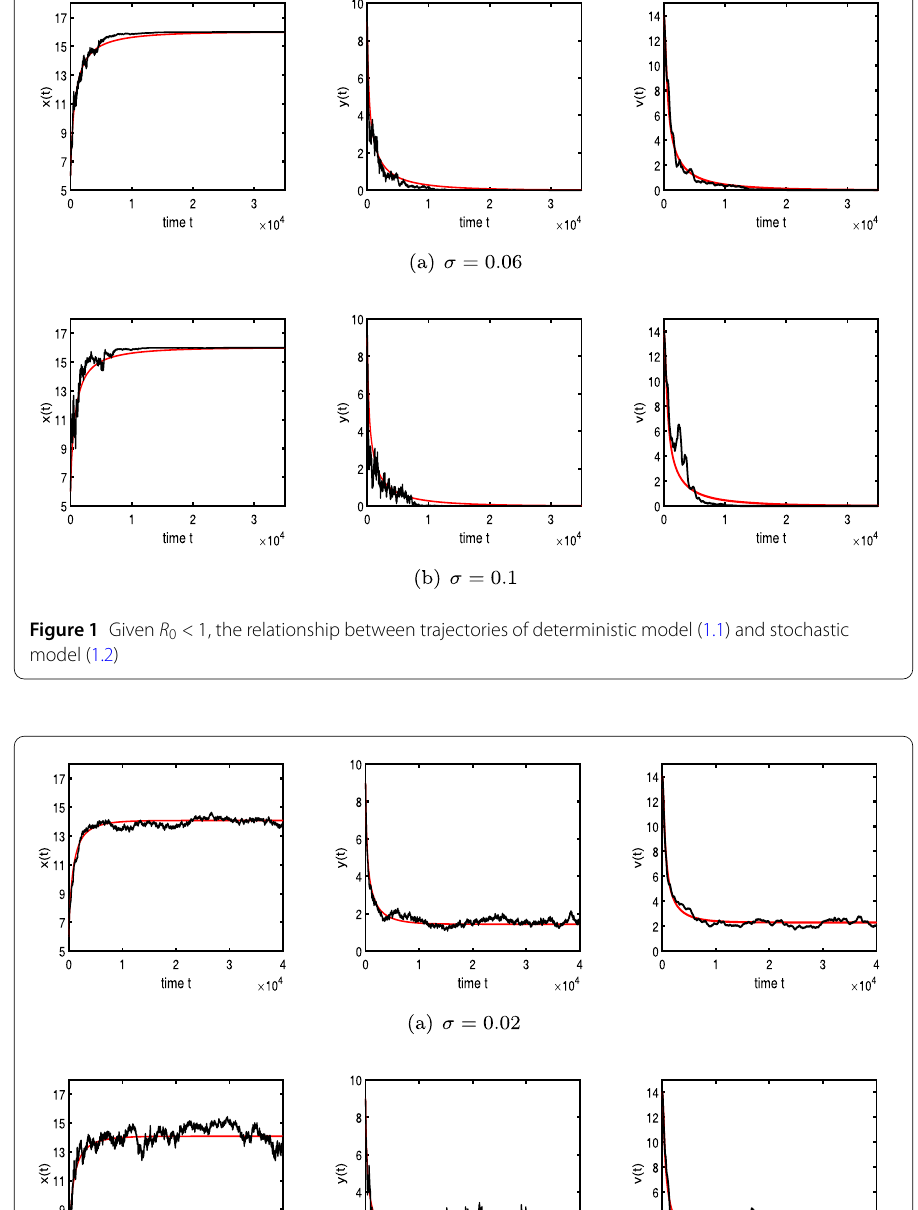
decreases, oscillations around the corresponding deterministic model reduce. Our model can well reflect the mutual interference between the concentration of uninfected CD4 + T cells and HIV viruses biologically. The Beddington–DeAngelis functional response of